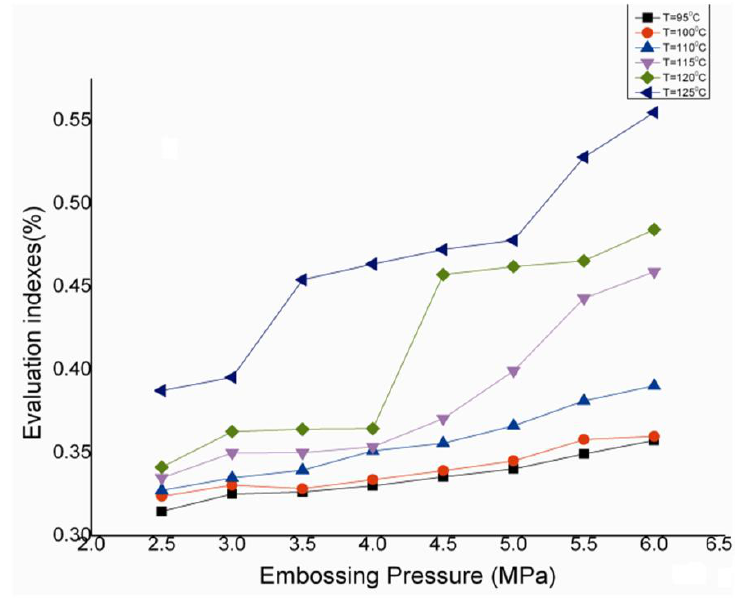
Figure 9. The relationship between embossing pressure and evaluation indexes (depth/thickness) under different temperatures.